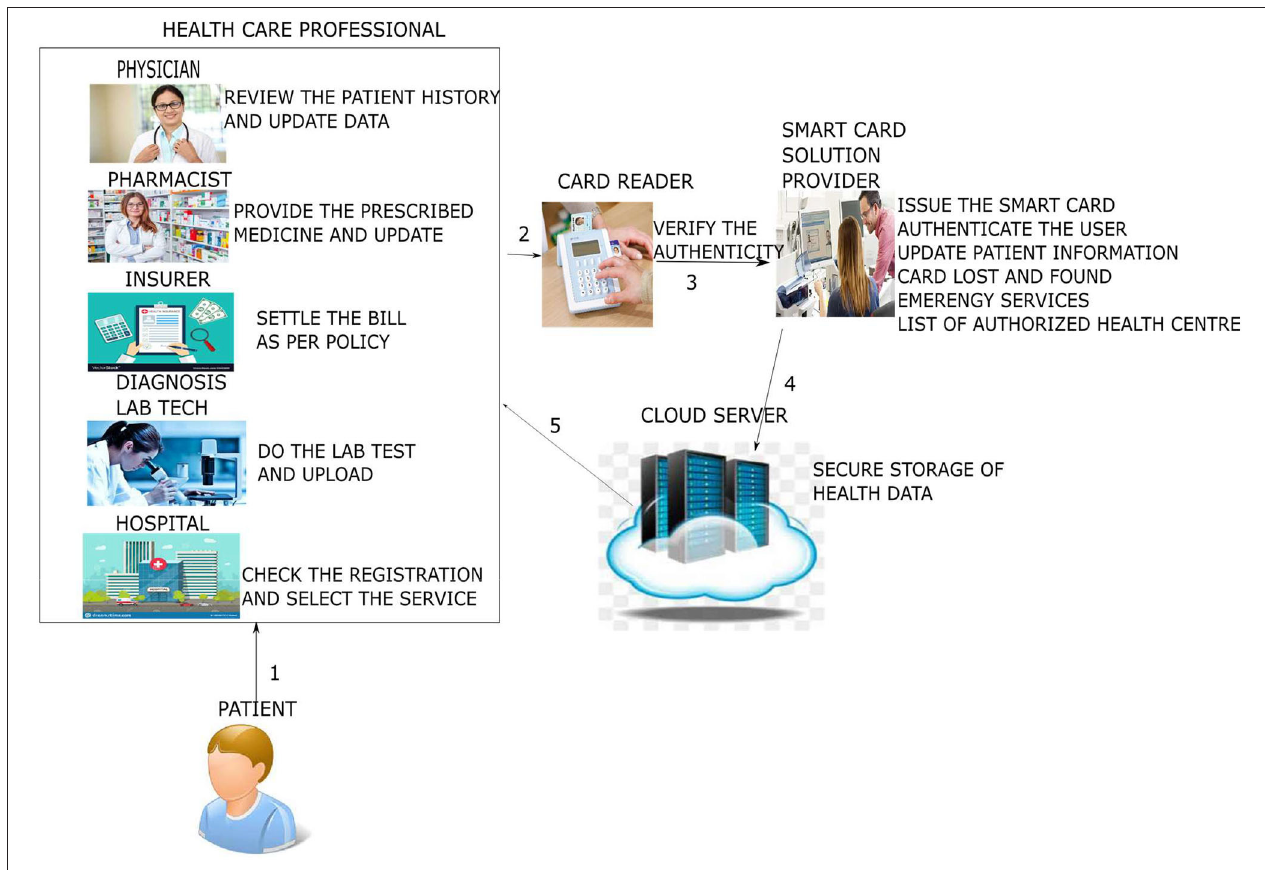
FIGURE 1 | System